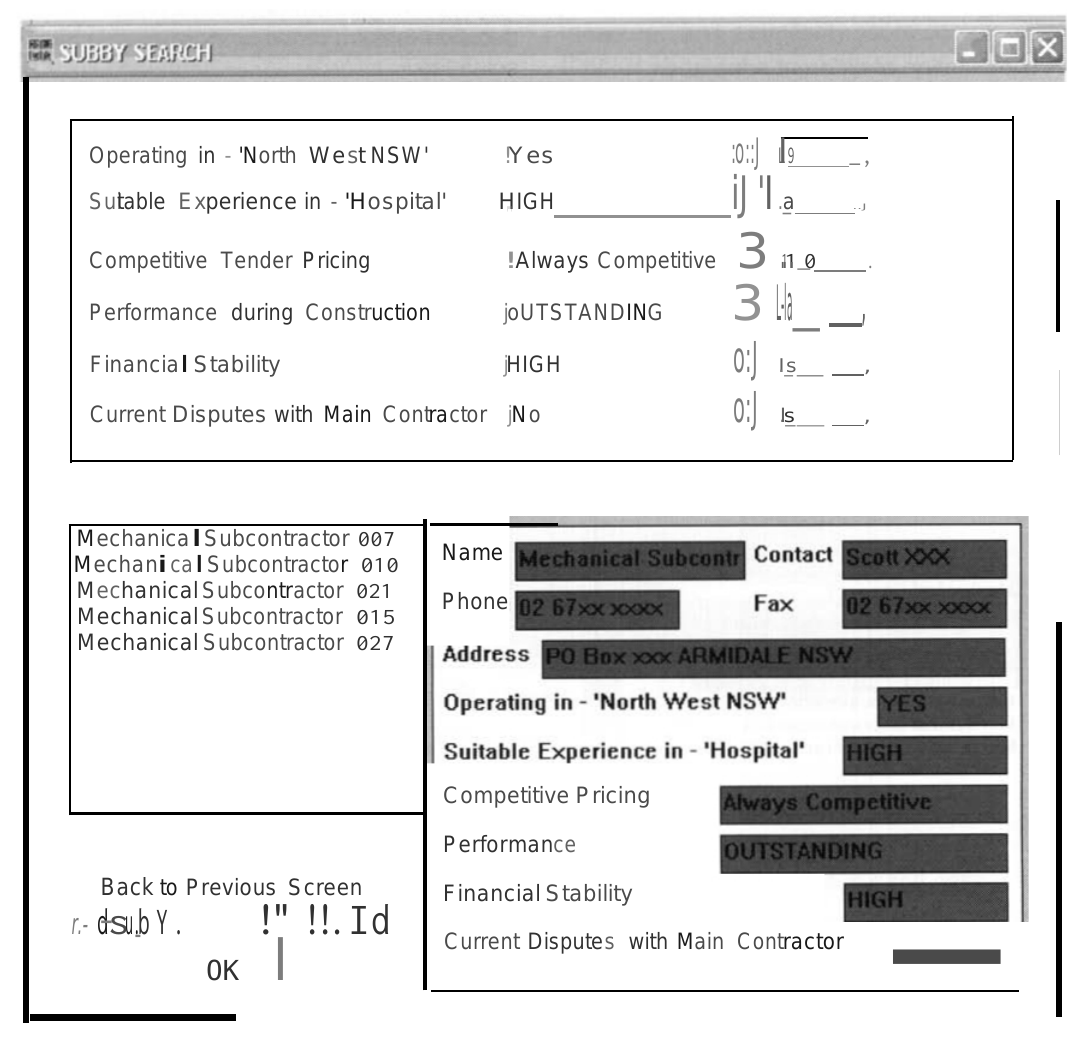
Figure 6: Critic-based adaptation using user's knowledge and